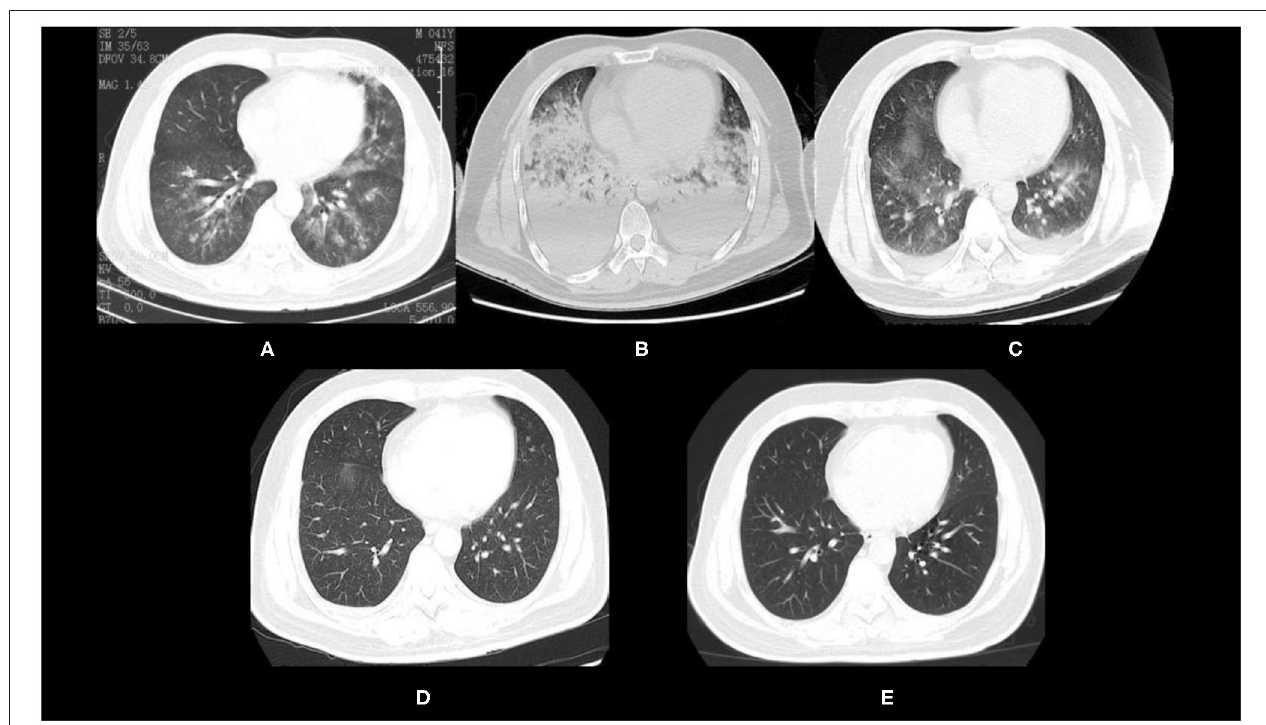
FIGURE 3 | Chest CT of the patient after mixed chemical gas inhalation. (A) Chest CT 2h after inhalation. (B) Chest CT 20h after ECMO initiation. (C) Chest CT after ECMO was weaned off. (D) Chest CT 2 days after weaning. (E) Chest CT 54 days after discharge.